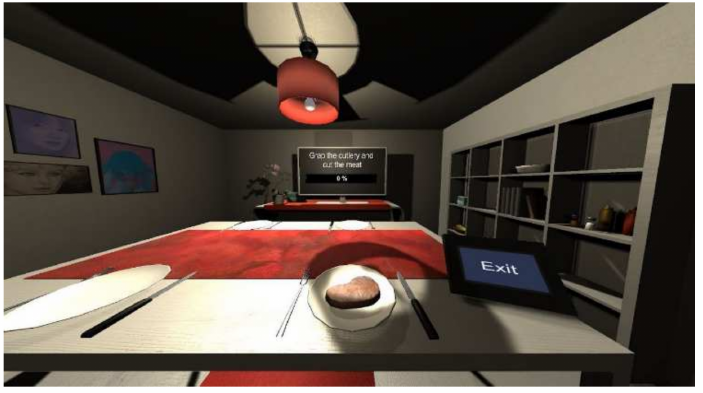
Figure 4. Cutlery